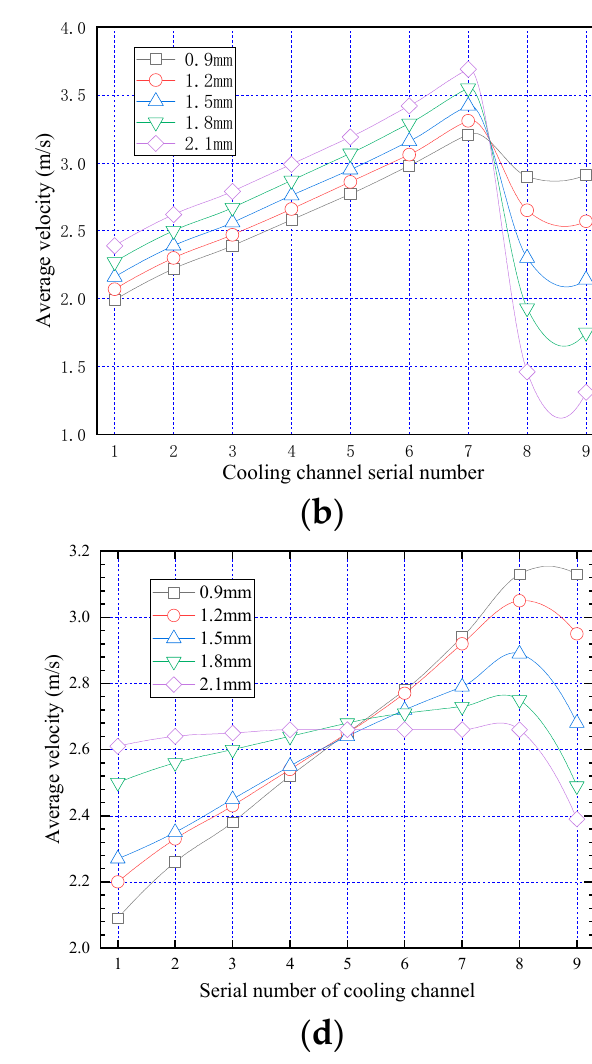
Figure 11. Effect of the length of parallel plates on temperature and velocity distribution of the model; ( a ) temperature distribution in case2; ( b ) velocity distribution in case2; ( c ) temperature distribution in case9; ( d ) average distribution in